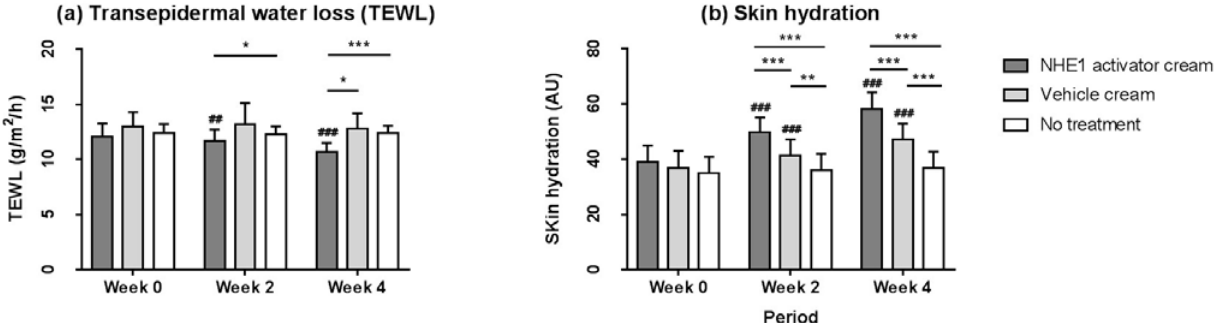
Figure 6. Changes in transepidermal water loss (TEWL) and skin hydration after application of the NHE1 activator cream or vehicle cream. ( a ) TEWL was measured after application of the NHE1 activator cream ( M. officinalis leaf extract 0.05% and rosmarinic acid 0.1%) on the forearm and vehicle cream on the other forearm. ( b ) After topical applications (NHE1 activator cream or vehicle cream), skin hydration was assessed. Data are presented as the mean ± SD ( n = 21). Repeated measures ANOVA, independent samples t -test, Wilcoxon signed-rank t -test, and Mann–Whitney U test p -values indicate statistical significance (* p < 0.05, ** p < 0.01, and *** p < 0.001; ## p < 0.01, and ### p < 0.001).